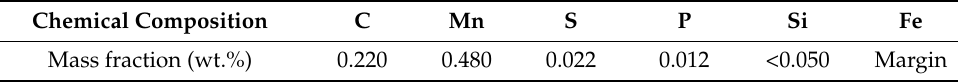
Figure 1. The SEM photograph of the aluminum powder. Table 1. Chemical composition of Q235 steel. Table 1. Chemical composition of Q235